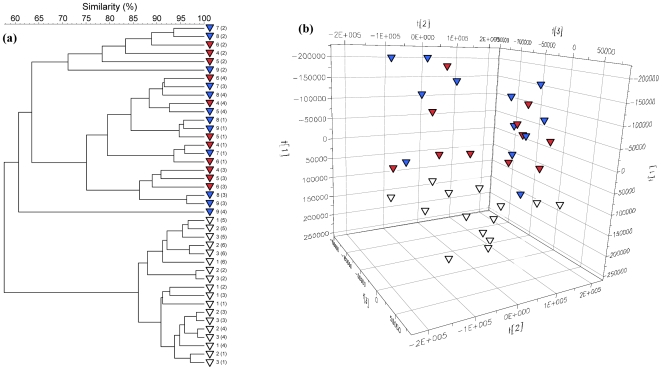
Age-dependent effects of relocation on the GTM profiles and urinary metabolite profiles of C3H mice.(a) UPGMA cluster analysis of fecal DGGE profiles. Blue symbols represent fecal samples obtained from animals housed in the original environment (A). Samples obtained from mice relocated at 4 weeks of age are represented by open symbols; red symbols represent animals relocated to environment B at over 8 weeks of age. Numbers identify individual animals; numbers in parenthesis give the age of animal in weeks and (b) UPLC-MS PCA results from the analysis of urine samples from these animals showing the effect of relocation on metabolite profiles.